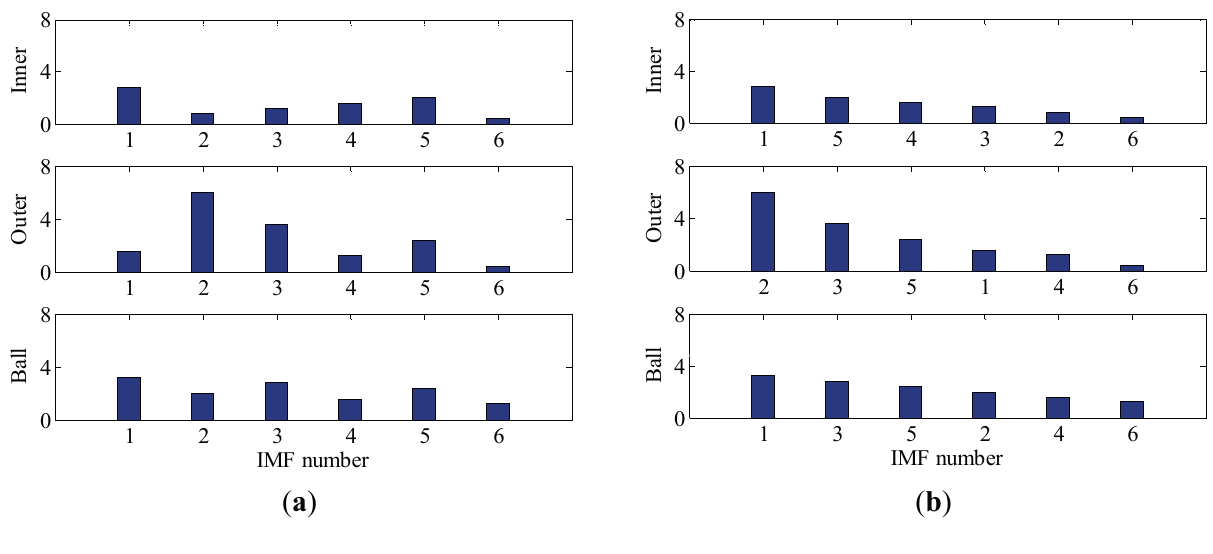
Figure 2. The bar plot of FSM: ( a ) before sorting; ( b ) after